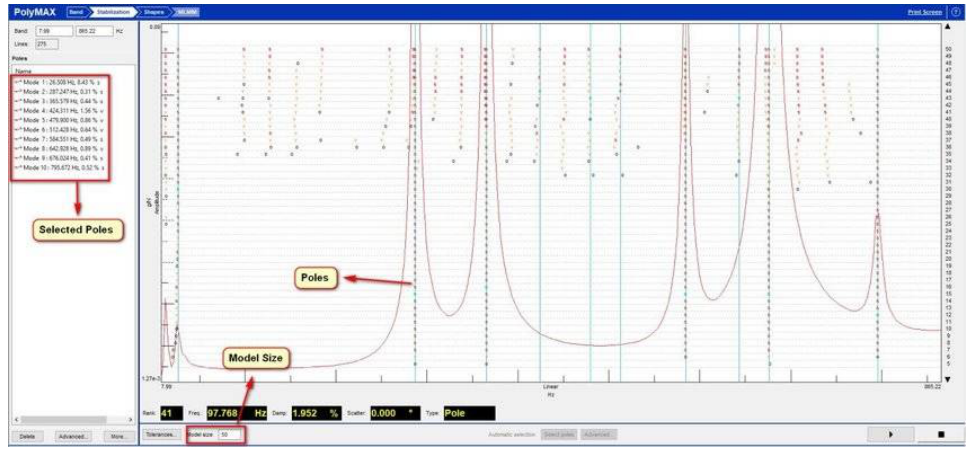
Figure 4. Stabilization diagram. Notations: order = order of the pole, o = unstable pole, f = pole has a constant frequency. v = pole has a constant frequency and modal vector; s—stable pole.